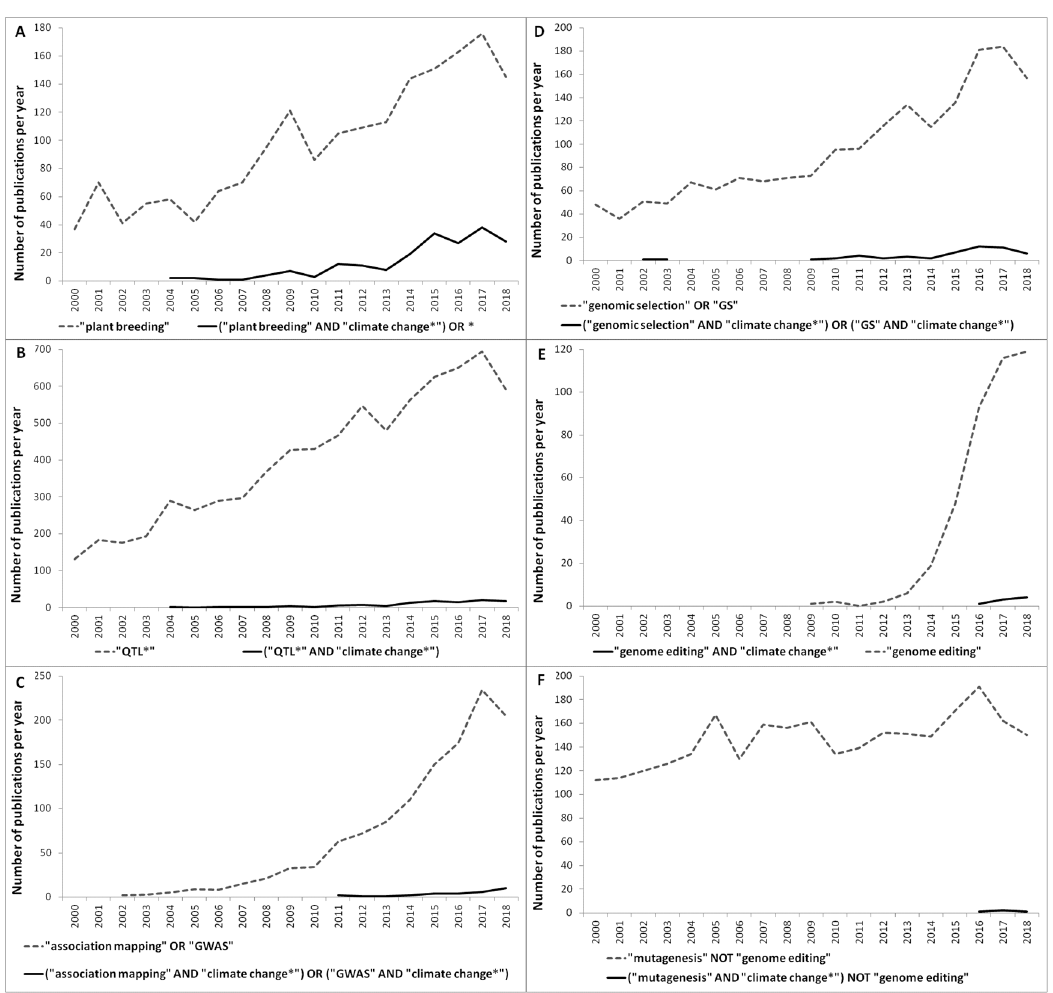
Figure 1. Number of publications in which the most recent and breakthrough technologies applied to plant breeding are associated ( ___ ) or not (---) with climate change. ( A ) Keyword: plant breeding; ( B